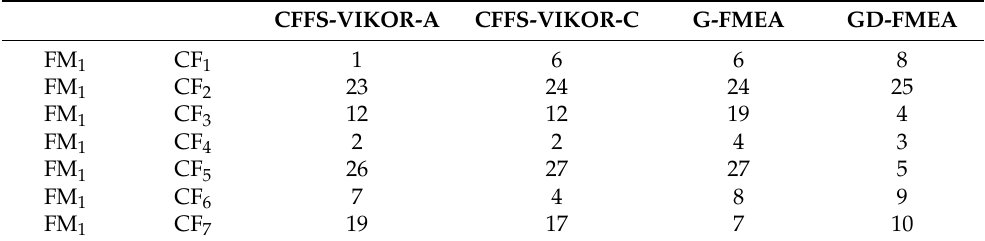
Table 17. Comparison regarding the priority of CFs related to FM 1 , FM 4 , FM 5 , FM 6 and FM 7 , which are ranked as the top three by at least one of the compared